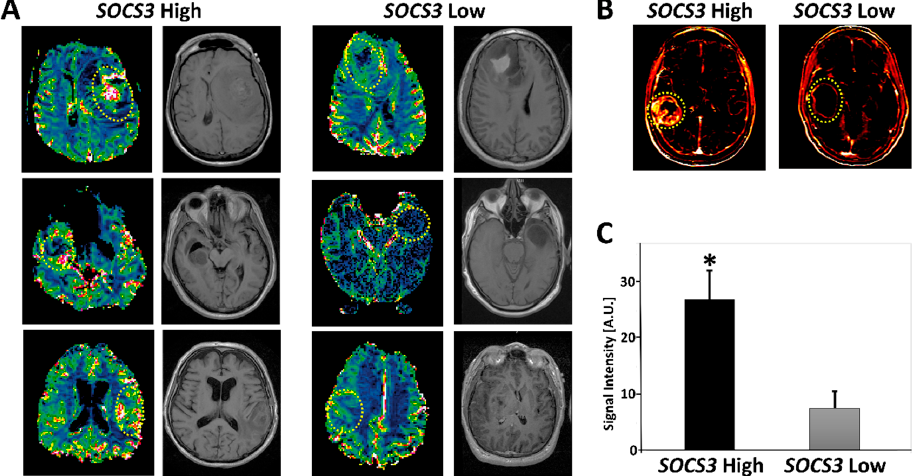
Figure 5. Radiogenomics of SOCS3 expression in GBM. ( A ) Representative dynamic susceptibility contrast-MRI (DSC-MRI) images with higher than the median SOCS3 expression and lower than the median SOCS3 levels. Circles represent regions of interest (ROIs). ( B ) Dynamic contrast-enhanced (DCE)-MRIs of higher than the median (TCGA-06-5412) and lower than the median (TCGA-06-2570) SOCS3 expressions. ( C ) Quantification of 3D tumor volume perfusion intensity in groups with differential SOCS3 expression levels. *: p < 0.05.